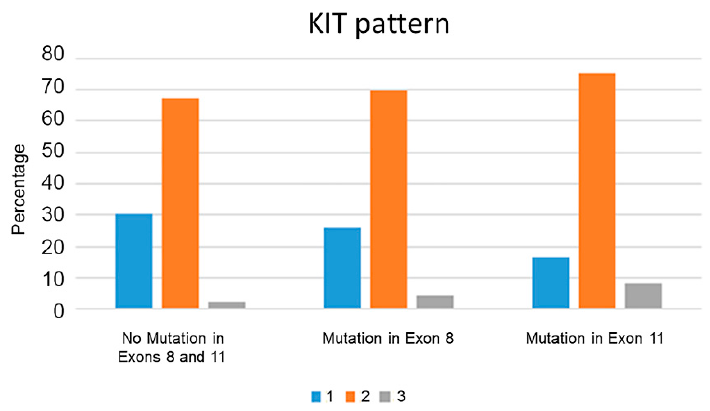
Figure 3. Histogram of percentage of KIT patterns (1 (perimembranous; blue), 2 (focal or stippled cytoplasmic; orange), and 3 (diffuse cytoplasmic, gray)) in subcutaneous mast cell tumors with different mutation status. While there was an overall increase in aberrant labeling (patterns 2 and 3) in mast cell tumors with an internal tandem duplication mutation in exon 11, there was no statistically significant difference.